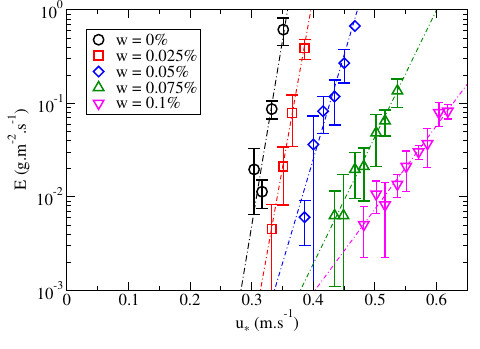
Figure 3. Erosion rate as a function of the friction speed u ∗ for di ff erent liquid content w . The dash lines represent exponential fits to the data.